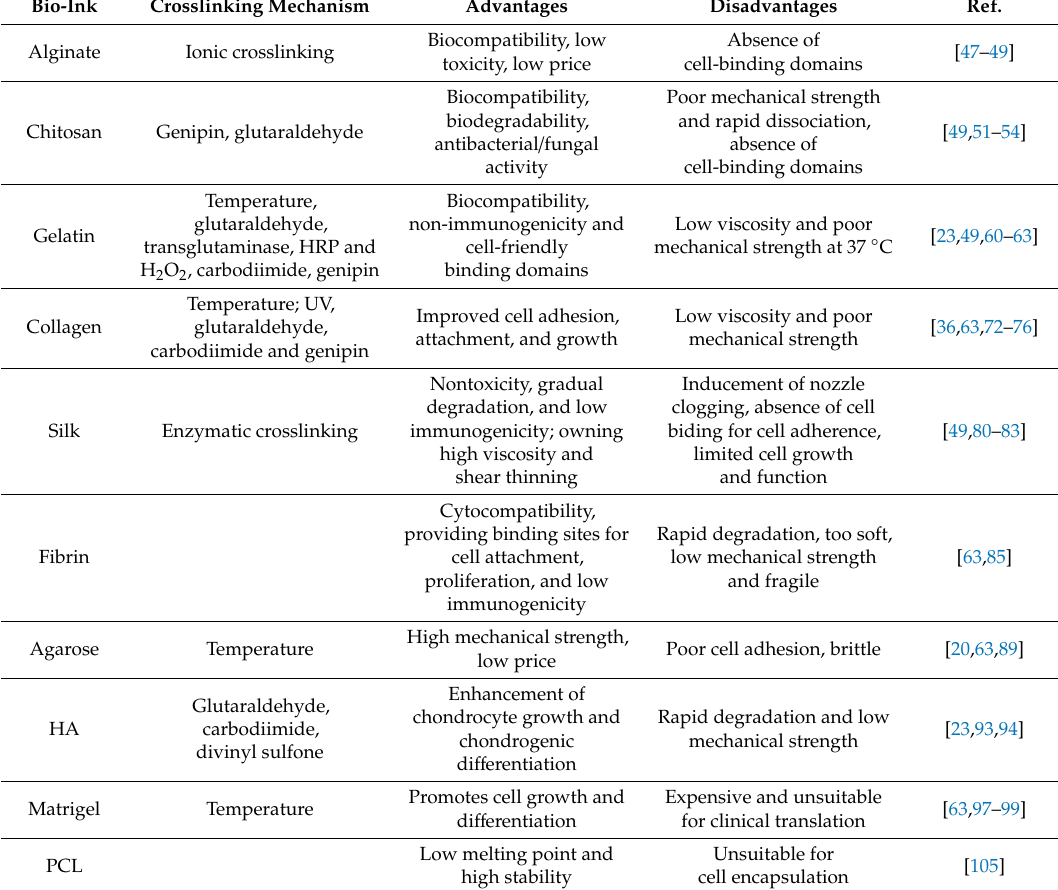
Table 1. Current natural and synthetic bio-inks widely used for 3D